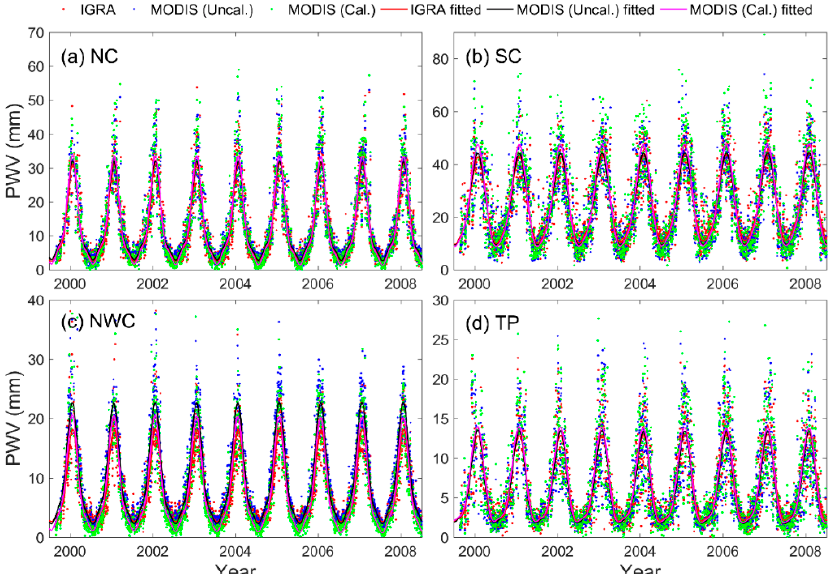
Figure 14. Distributions of PWV time series in the four areas of Mainland China over the period